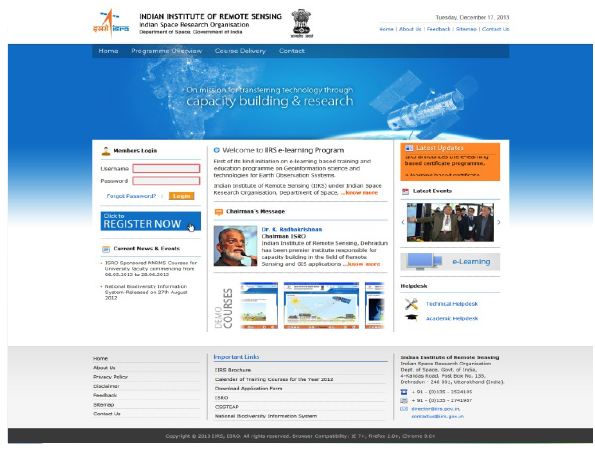
Figure 2: Indian Institute of Remote